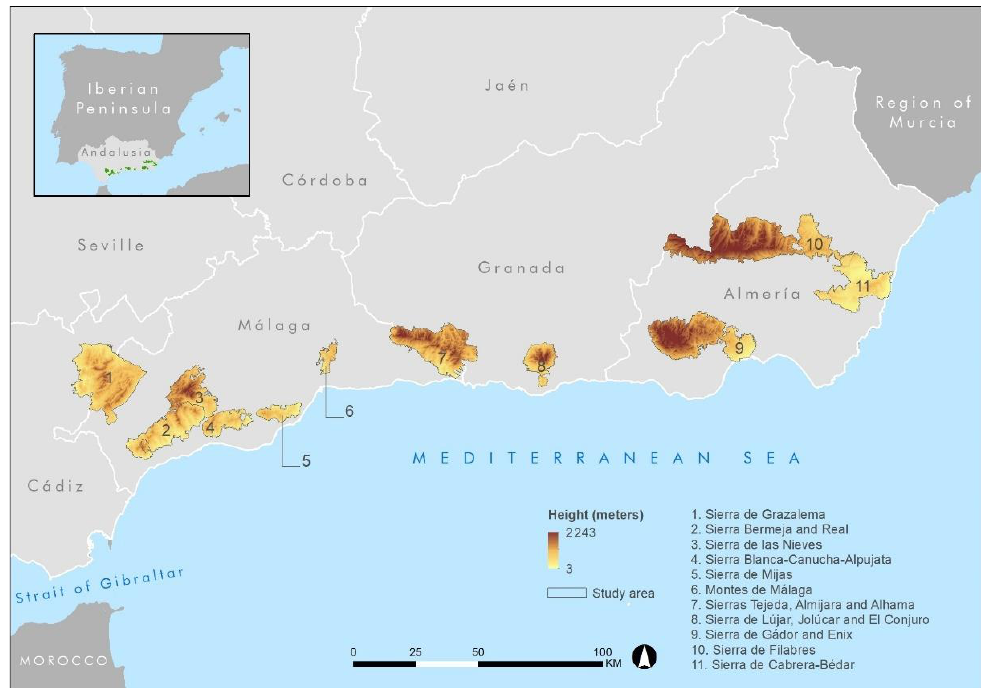
Figure 2. Representation of relief of the study area and selected natural areas. Own elaboration based on Basic Spatial Data of Andalusia (DERA). Statistical and Cartographic Institute of Andalusia. Government of Andalusia.